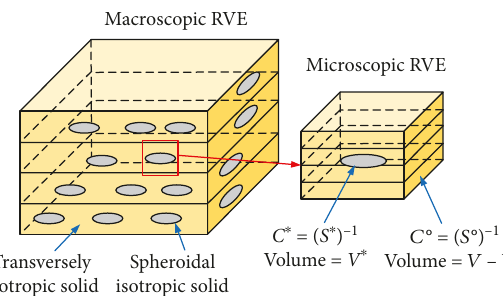
Figure 11: The schematic diagram of the medium model with a spherical pore.